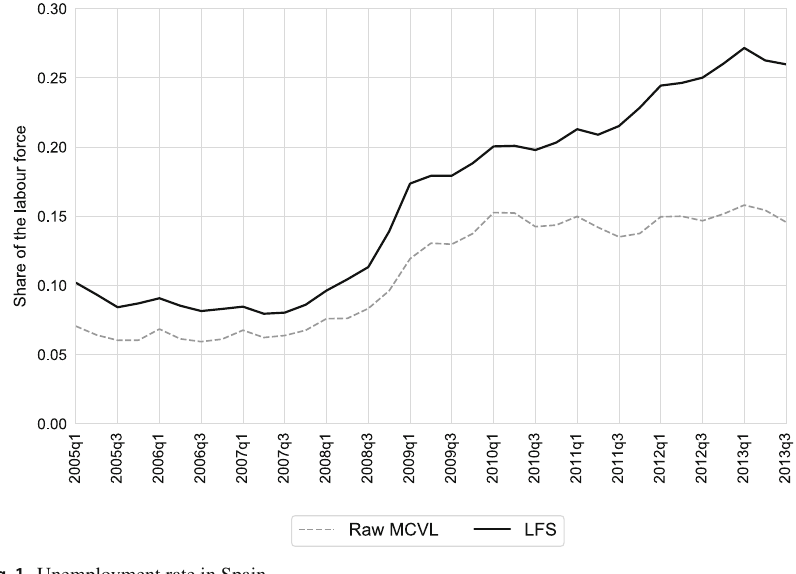
Fig. 1 Unemployment rate in